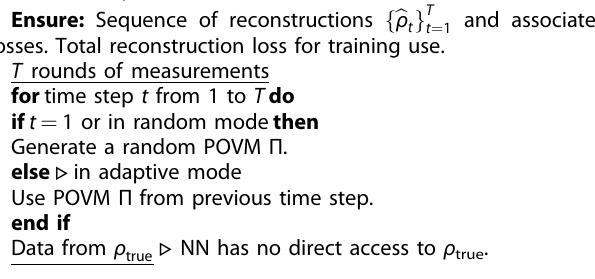
Algorithm 1 . Training